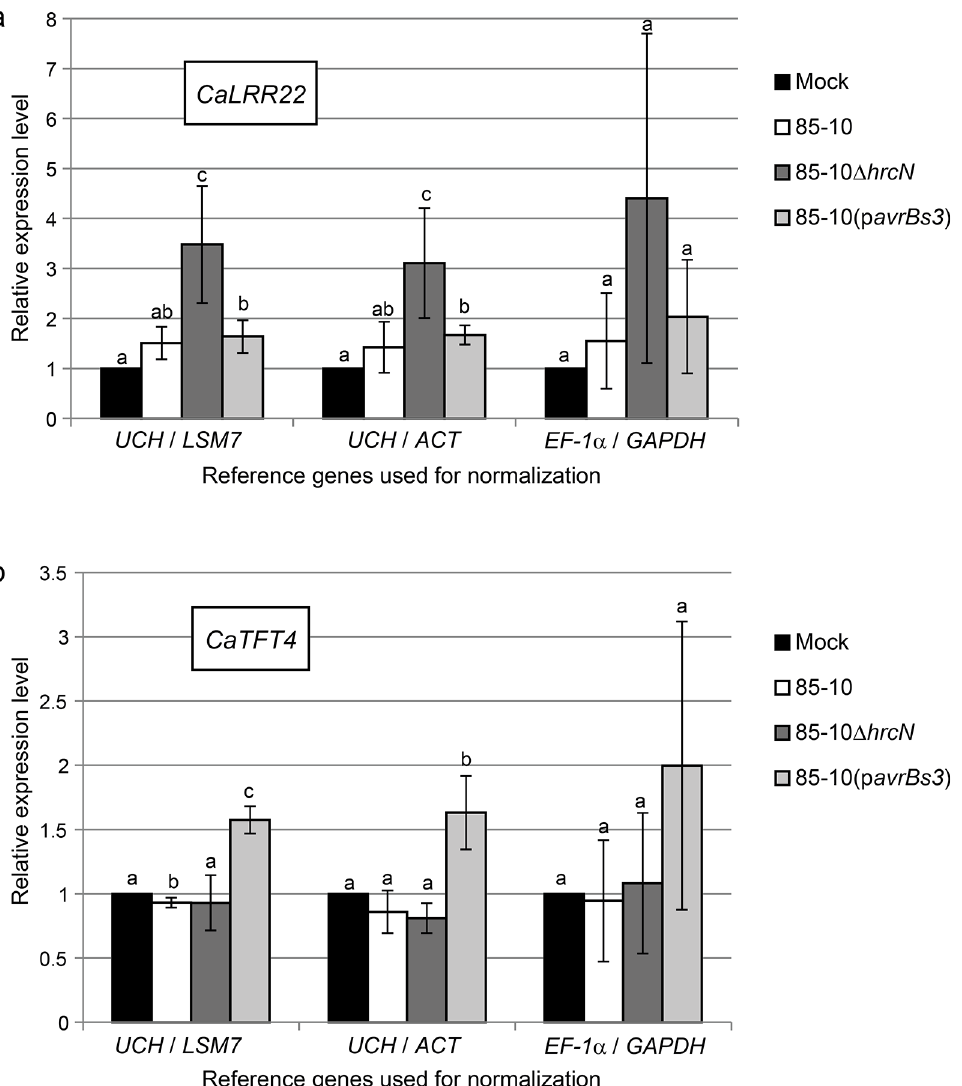
Fig 9. Relative expression of PTI and ETI marker genes in Xcv -infected and mock-treated pepper leaves. Expression patterns of CaLRR22 (a) and CaTFT4 (b) in C . annuum ECW-30R leaves treated with 10 mM MgCl 2 (mock) or 5×10 8 cfu/ml of Xcv 85 – 10, 85 – 10 Δ hrcN and 85-10(p avrBs3 ), respectively, six hpi. qRT-PCR data were normalized with different reference gene pairs. Values are mean fold changes in mRNA levels in Xcv -infected relative to mock- inoculated leaves for three biological replicates. Error bars indicate SD. Letters denote statistically significant differences (Student´s t -test, P <